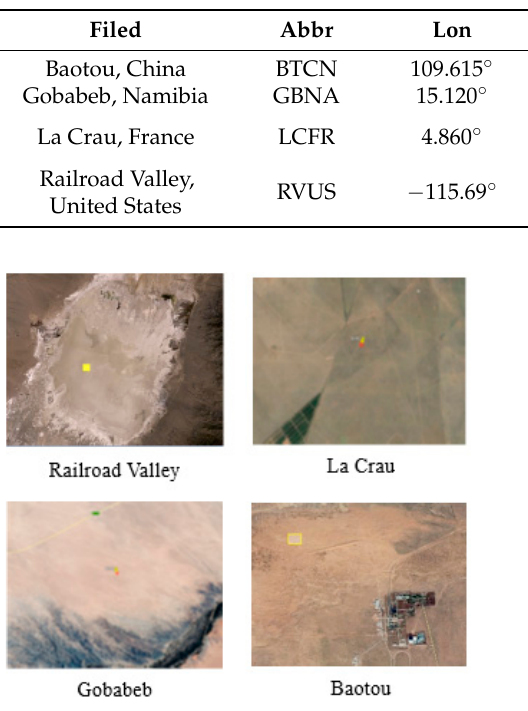
Table 2. Calibration site information.